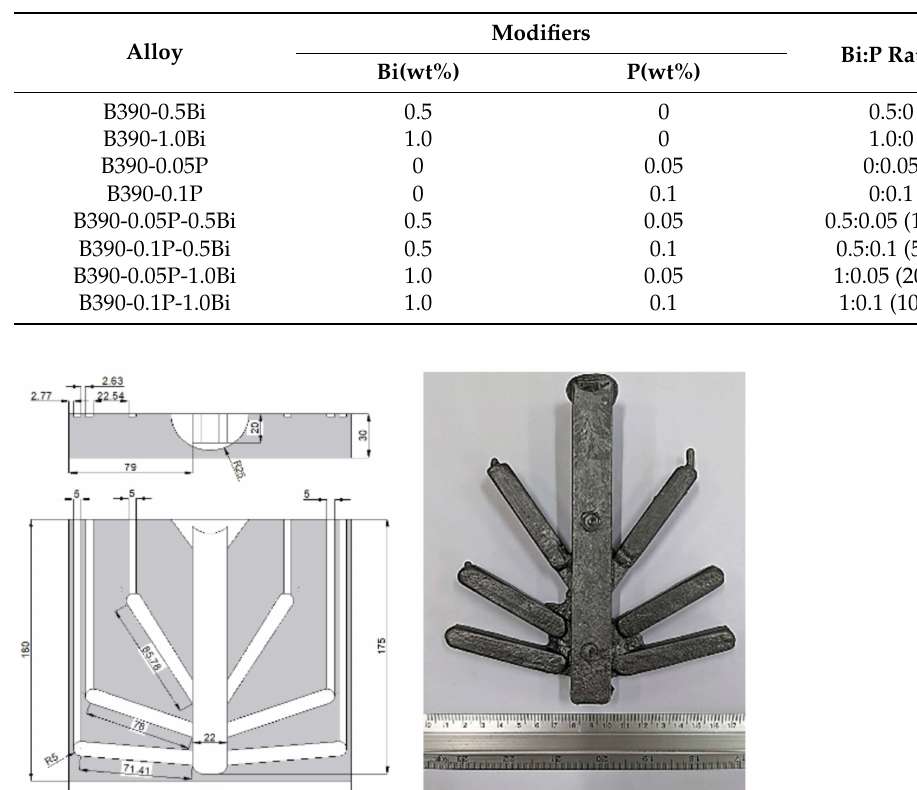
Table 2. Chemical compositions of the modified alloys (wt%).